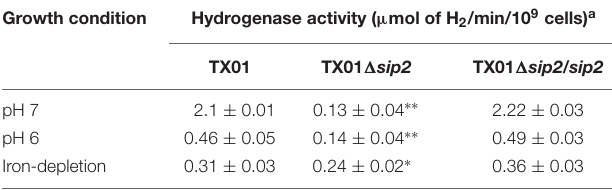
TABLE 1 | Hydrogenase activity of Edwardsiella tarda under different conditions.